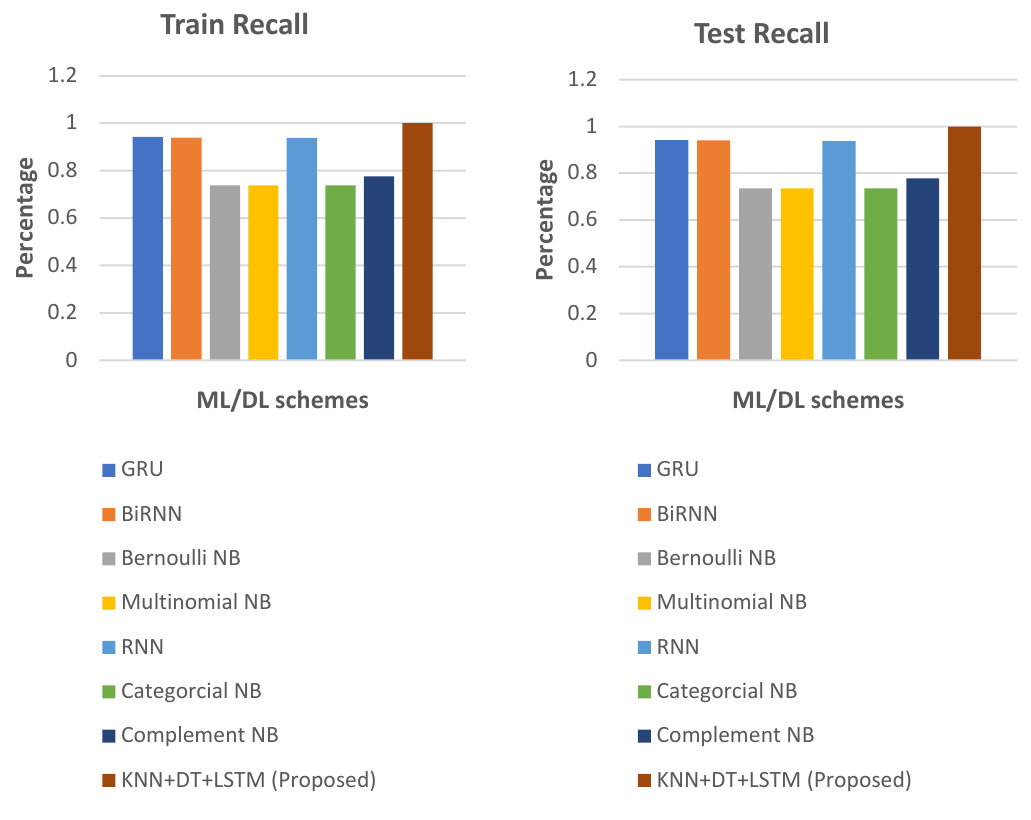
Figure 14. Training and Test Recall of Different Models. The F1 score is the harmonic mean of precision and recall. It is used to combine classifiers with different precision and recall. Figure 15 shows the training and test F1 scores of different models. Tables 2 and 3 show the performance metrics of different ML/DL models with training and testing.